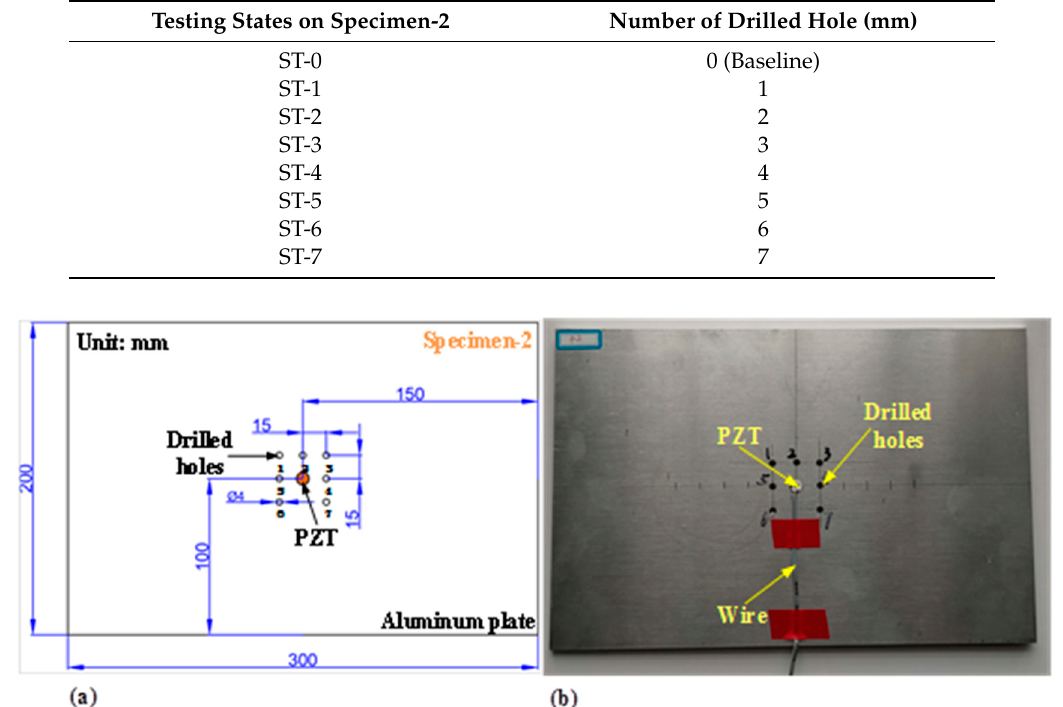
Figure 3. Simulated damage severity development by adding drilled holes on specimen-2: ( a ) distribution of seven drilled holes, ( b ) experimentally fabricated specimen with seven drilled holes.